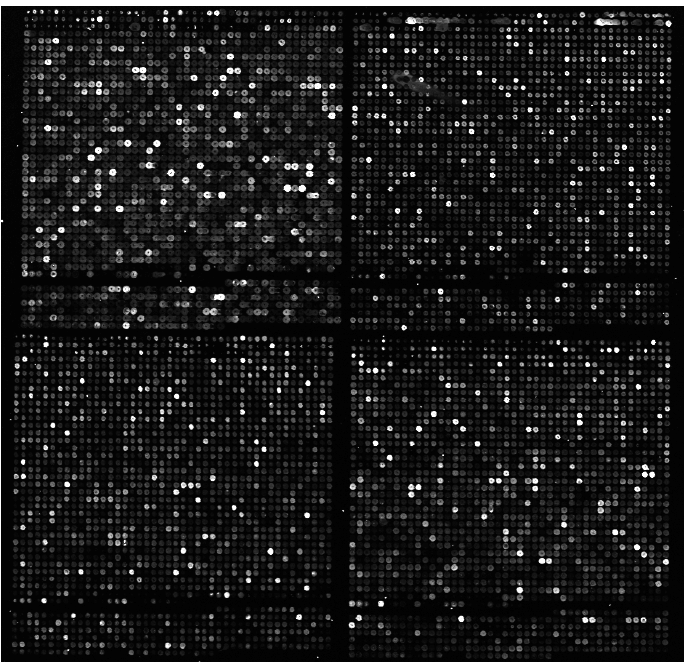
Figure 1. 940 × 910 portion of red channel image y744n43 ch2.tif from the Yeast dataset. Gamma levels have been adjusted in the figure for better